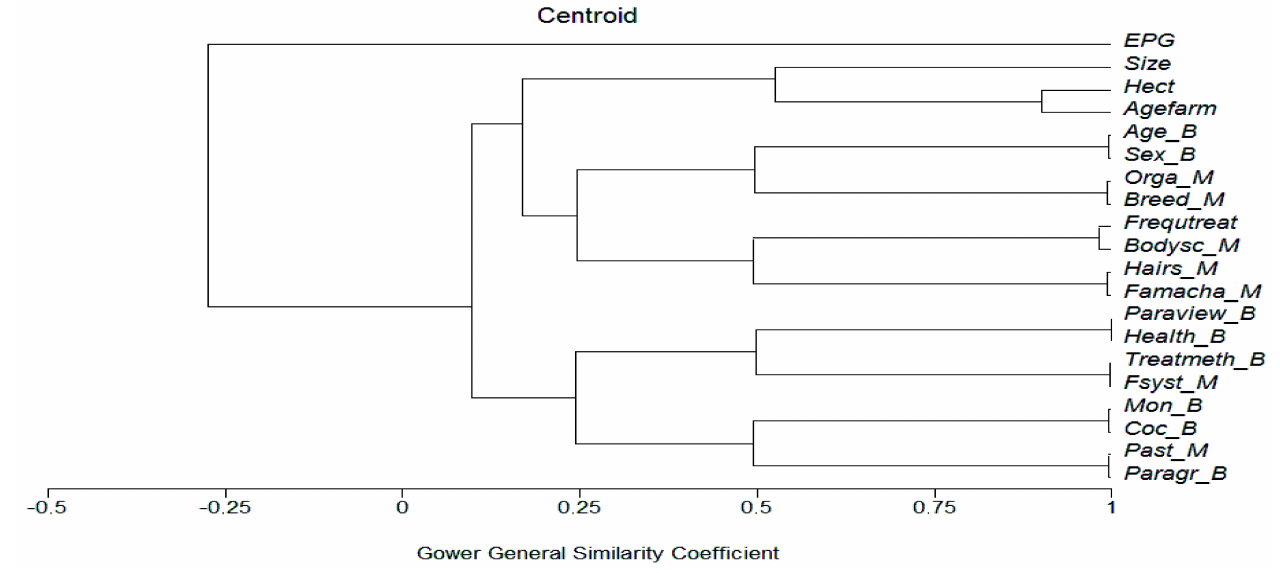
Figure 1. Cluster analysis of the relationship between infestation and the farm characteristics: Quantitative, Binary (B), Multistate (M), nematode eggs per gram of feces (EPG), size of the herd (Size), surface area of the farms in hectares (Hect), age of the farms (Agefarm), age of goats—adult or kids (Age), sex of goats—male or female, farm organization—no pasture, pasture and pen, only pasture (Orga), (Breed), frequency of treatment (Freqtreat), body score condition (Bodysc)—0 very poor to 5 very good, FAMACHA© (Famacha)—very good, good, average, bad, very bad, hair appearance (Hair)—shiny, normal, spiky and dull, farmer’s view on parasites (Paraview) and health (Health), treatment method—all or target selective treatment (Treatmeth), farming system (Fsyst)—professional husbandry, agriculture and husbandry, traditional husbandry, husbandry organization (Orga)— breeder association, cooperative, independent, Moniezia—presence, absence (Mon), coccidian— presence, absence (Coc), use of pasture (Past)—yes or no, farmer parents involved in agriculture—yes or no